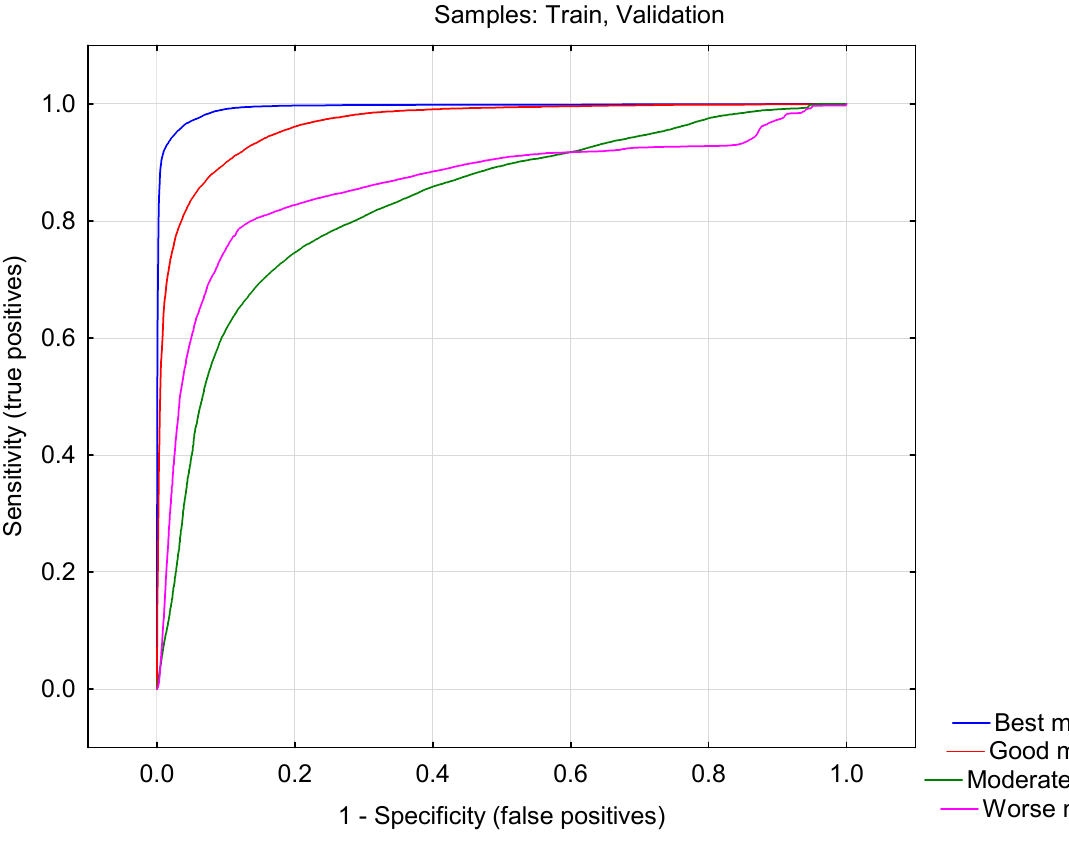
or multiple enzyme family targets. To do so, we calculated the accuracy of the model